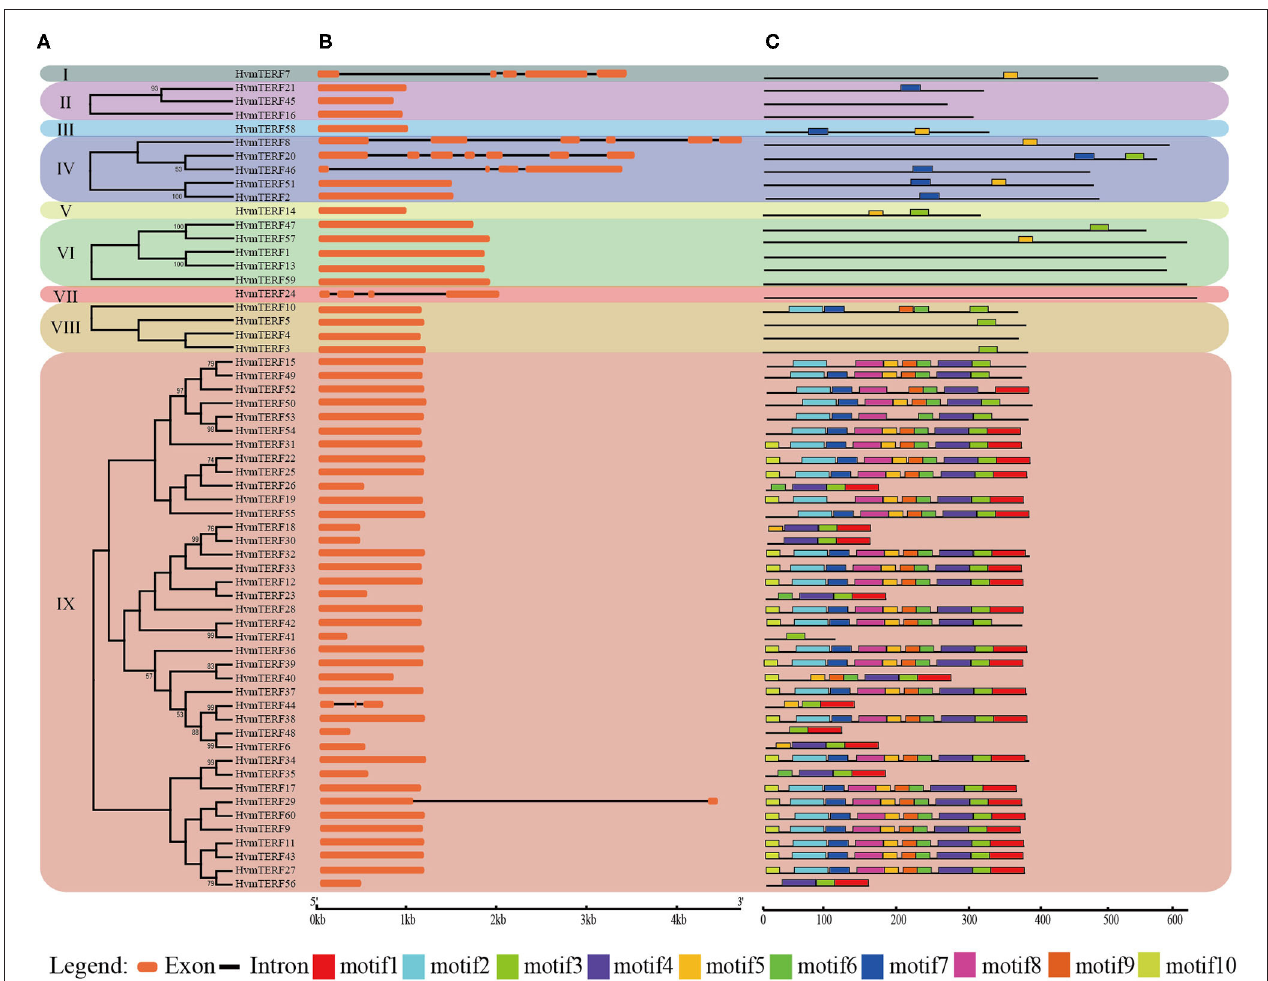
FIGURE 2 | Phylogenetic tree, conserved motifs, and exon-intron structure analysis of HvmTERF s. (A) Phylogenetic tree for each subfamily. (B) Gene structure of HvmTERF genes. Exons are indicated as orange boxes. Black lines represent introns. (C) The motif composition of HvmTERF s. Motifs are designated as 1–10 and represented by different